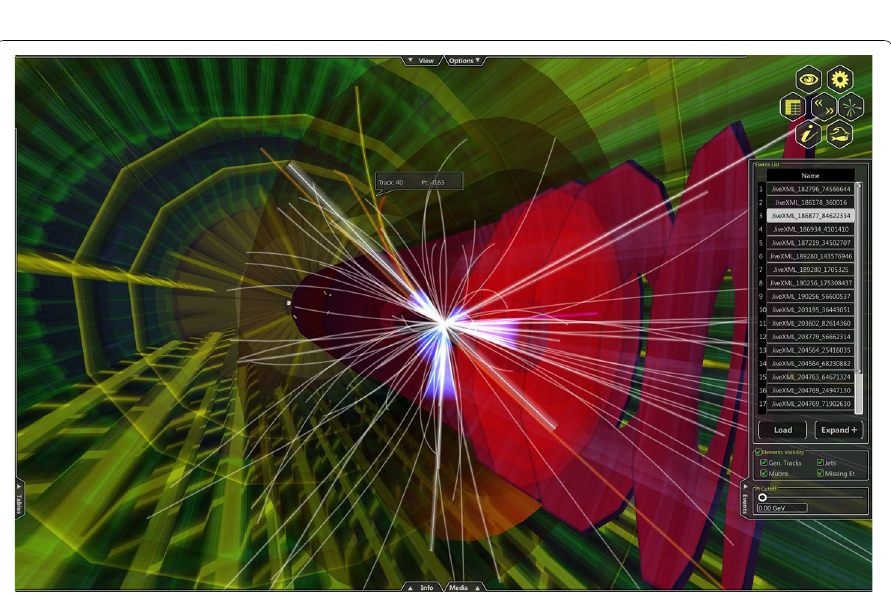
Fig. 24 A zoomed 3D visualization using the CAMELIA toolkit displayed on the Hiperwall that shows a subatomic particle decaying into several hadronic jets and lepton in presence of large background events inside the ATLAS